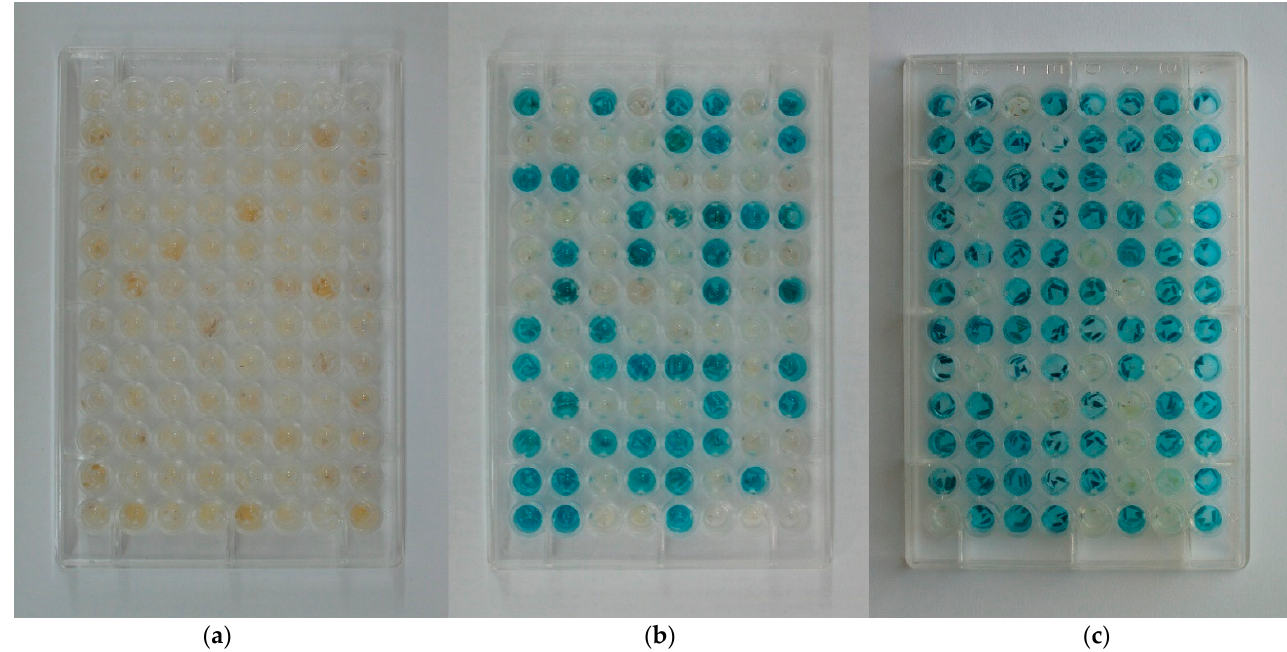
Figure 5. Segregation of GUS activity in pear progeny: ( a ) non-transgenic control; ( b ) ratio 1:1; ( c ) ratio 3:1.